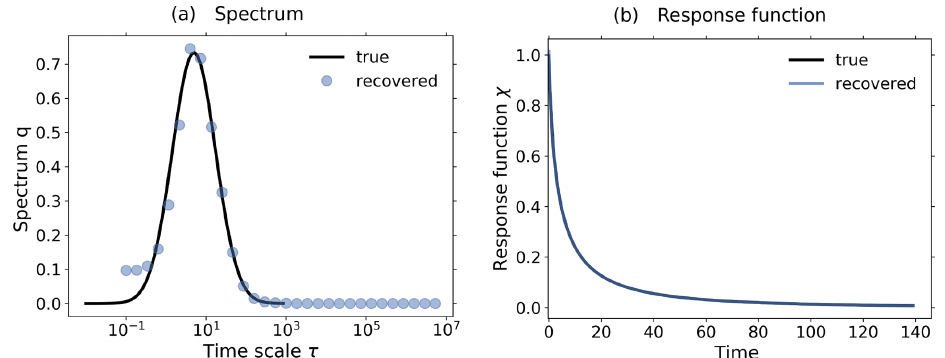
Figure E6. Response function χ(t) and spectrum q λ recovered from toy model data taking the RFI parameters M = 30, log τ min = − 1, and log τ max = 7. Blue dots in (a) and blue line in (b) indicate the recovered values for the spectrum and for the response function, while black lines indicate their “true” values.